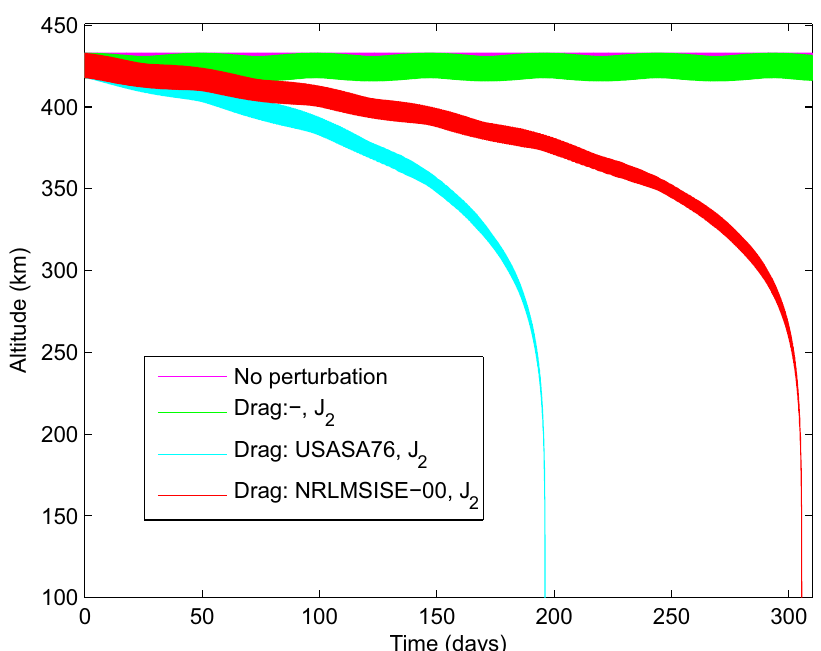
Figure 8. Altitude evolution for different perturbation models.